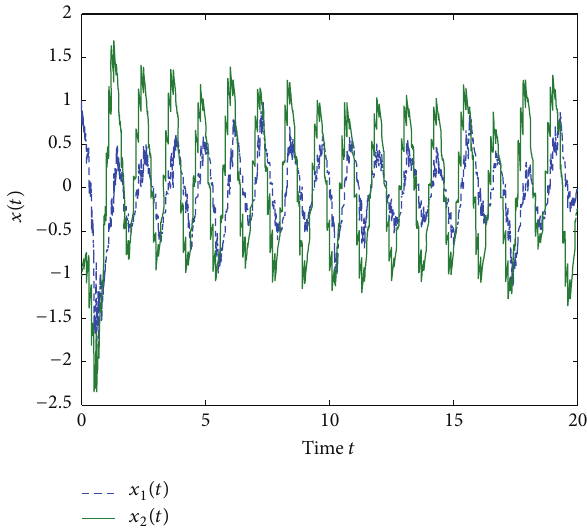
Figure 2: The state trajectory of the system with external input (single sample).